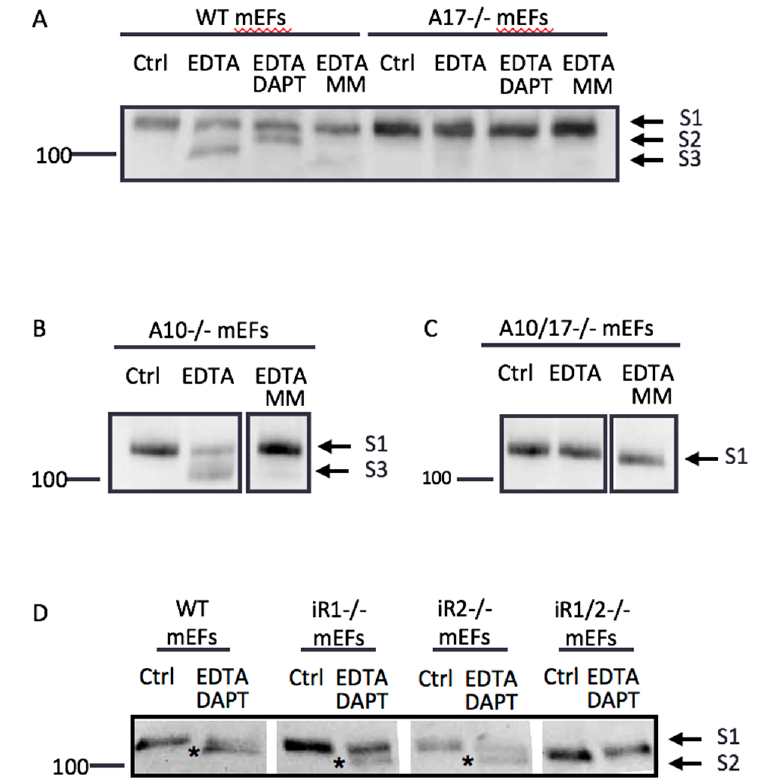
Figure 2. ADAM17 is the primary S2 protease involved in EDTA-induced endogenous Notch1 processing. Cells were treated with PBS (vehicle control, Ctrl), 5 mM of EDTA, or 5 mM of EDTA in the presence of the inhibitors DAPT (5 µ M) or marimastat (5 µ M MM, metalloprotease inhibitor that blocks ADAMs10 and 17) for 15 min. MM blocks the S2 cleavage, whereas DAPT blocks S3 processing. All the inhibitors were pre-incubated for 2 h in Opti-MEM and Western blots were performed using an anti-Notch1 cytoplasmic domain antibody. ( A ) Samples of WT mEFs treated with 5 mM of EDTA showed a band around the expected size of S3, which was not produced in the presence of DAPT. Instead, a fragment around the expected size of the Notch1 S2 product accumulated upon DAPT treatment. WT samples treated with EDTA and MM showed no S2 and S3 products. In contrast, mEFs lacking ADAM17 ( A17-/- mEFs) showed no S2 or S3 products under the conditions where these bands were observed for WT mEFs. ( B ) ADAM10-deficient mEFs ( A10-/- mEFs) showed the accumulation of an S3 product after EDTA treatment, which was blocked by MM, just like in WT mEFs. ( C ) Double-knockout mEFs deficient in ADAM10 and ADAM17 ( A10/17-/- mEFs) resembled A17-/- mEFs in that they showed no S3 production in response to EDTA treatment. ( D ) mEFs deficient in the ADAM17 regulators iRhoms 1 and 2 (iR1/2-/- mEFs) also produced no S2 fragment in the presence of EDTA and DAPT, whereas the inactivation of either iRhom1 or iRhom2 ( iR1-/- or iR2-/- mEFs) did not prevent the generation of Notch1 S2 (indicated by an asterisk). All Western blots shown are representative of at least 3 independent